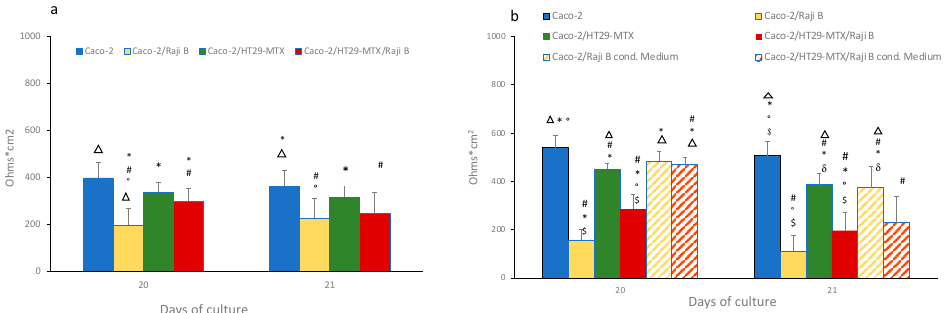
Figure 6. TEER evaluation in 1 ( a ) and 3 ( b ) µ m pore size insert at 20th and 21st days of culture. Results are the mean of three separate experiments performed in triplicate. Statistical analysis has performed by One-way Anova Test followed by post hoc test (Tukey’s ( p < 0.05) to evaluate group comparison. # versus Caco-2, * versus Caco-2/RajB; ◦ versus Caco-2/HT29-MTX; ∆ versus Caco-2/HT29-MTX/ Raji B, $ versus Caco-2/Raji B medium; δ versus Caco-2/HT29-MTX/ Raji B medium.